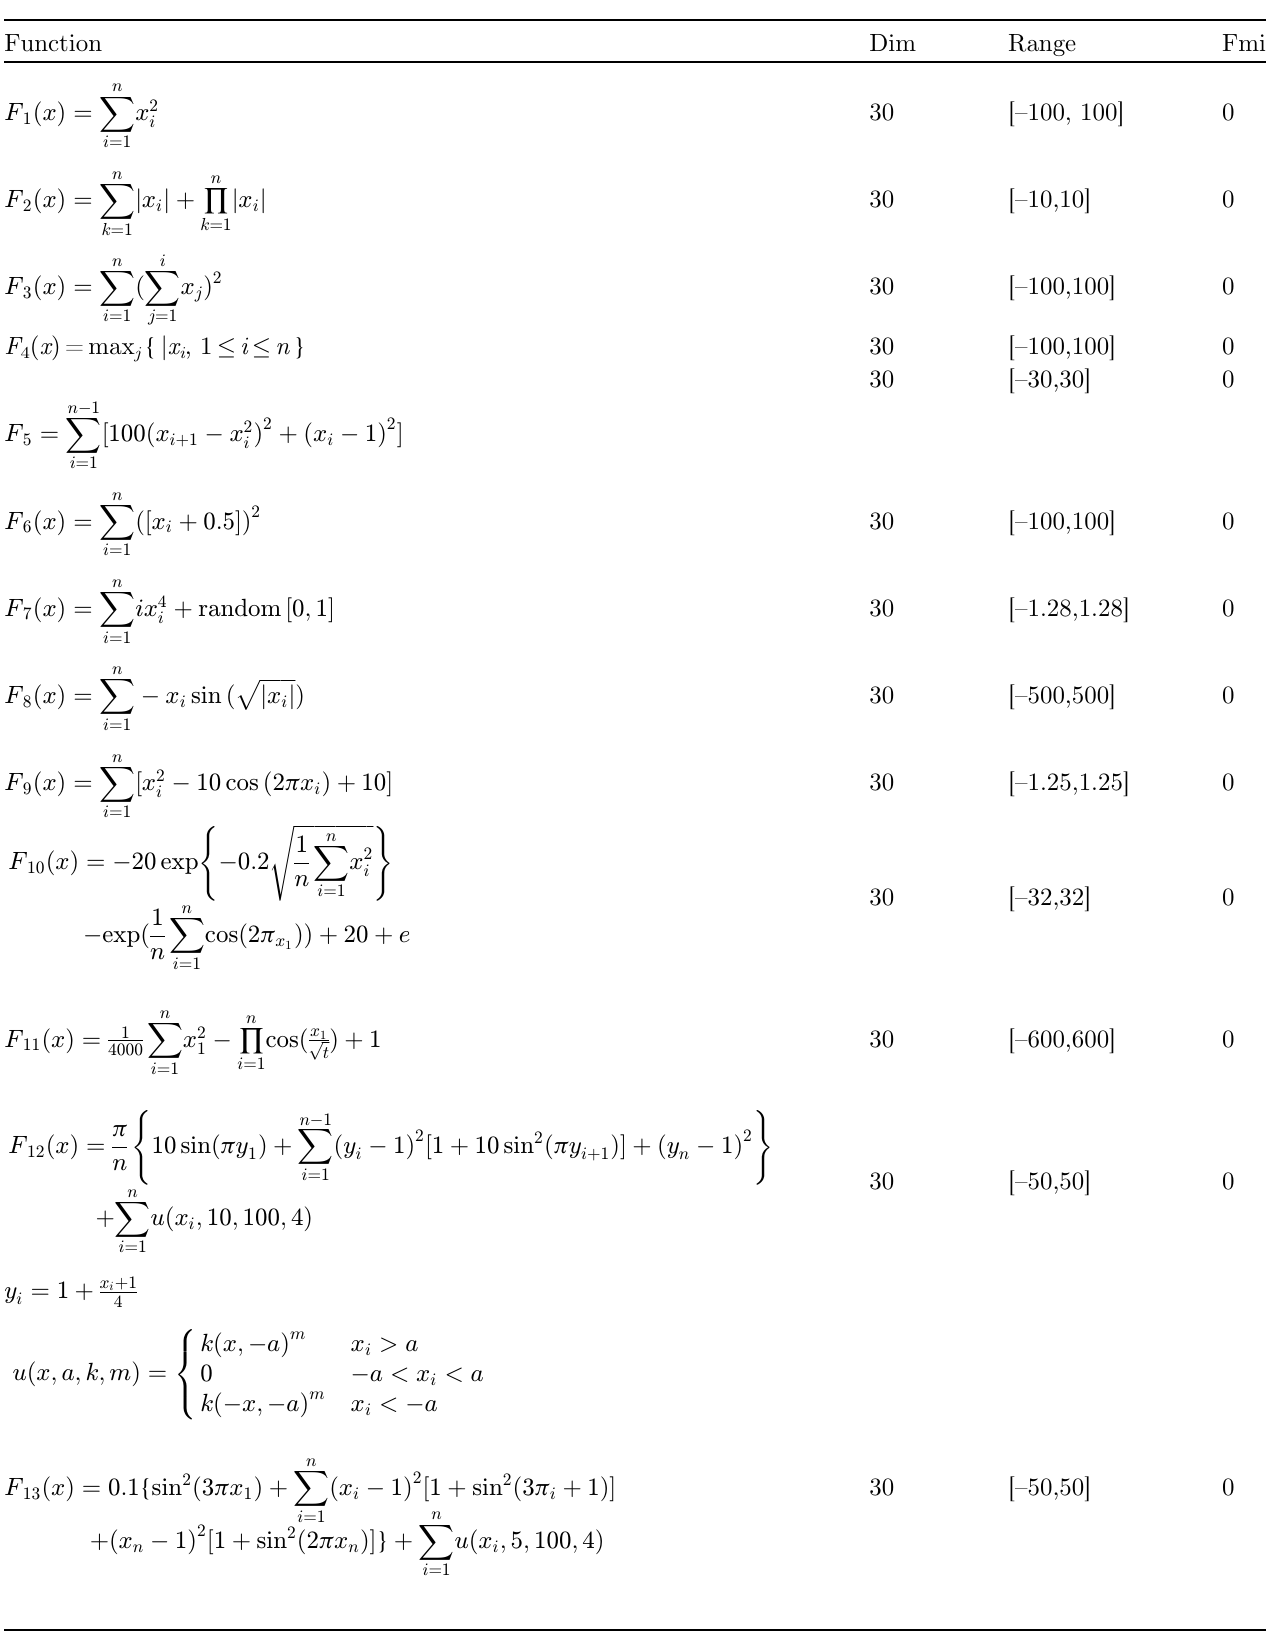
Table 4. Benchmark